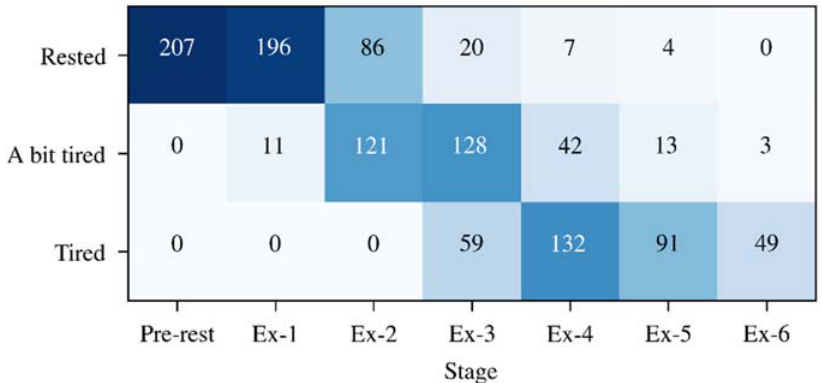
Figure 2. The distribution of the collected dataset.